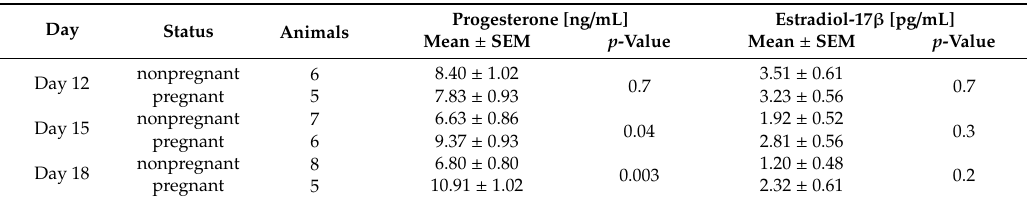
Table 1. Progesterone and estradiol-17 β concentrations at slaughter in the serum of cyclic and early pregnant Simmental heifers after insemination (insemination = Day